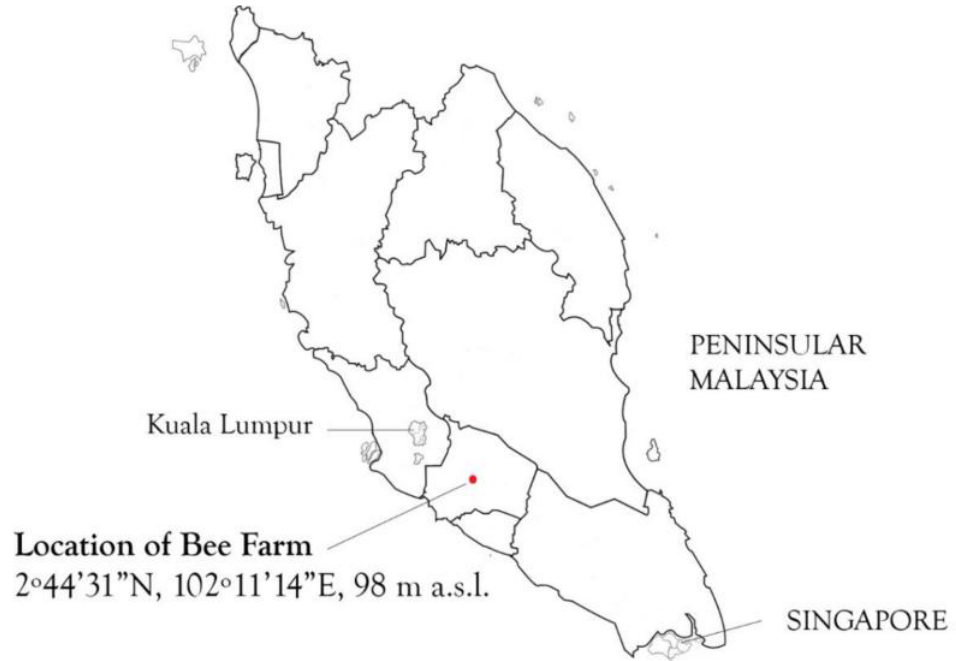
Figure 1. MapofpeninsularMalaysiashowingthelocationofthebeefarmwhere Hermetiaillucens and H.fenestrata (Diptera: Stratiomyidae) were found colonizing Geniotrigona thoracica (Hymenoptera: Apidae) nests.